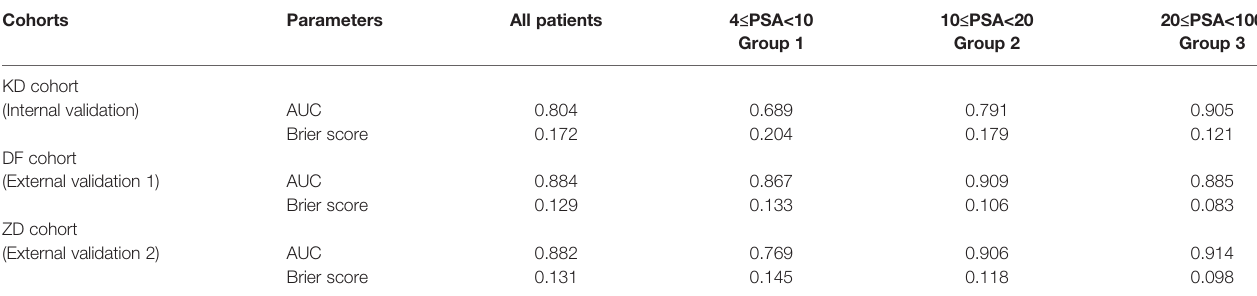
TABLE 3 | The results of internal and external validation of the nomogram in different PSA group.